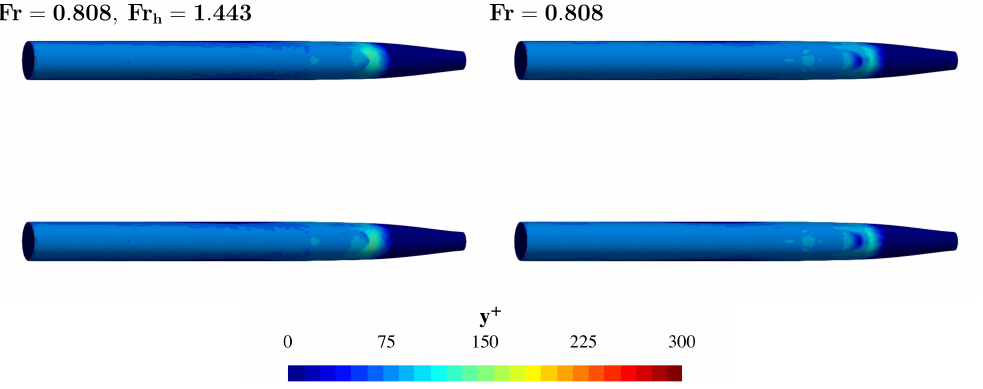
Figure 5. y + distribution on the demihulls.